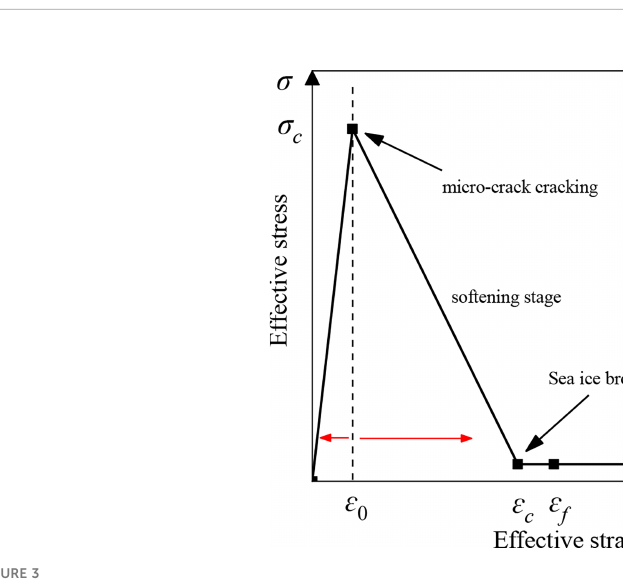
FIGURE 3 Ice solid element constitutive